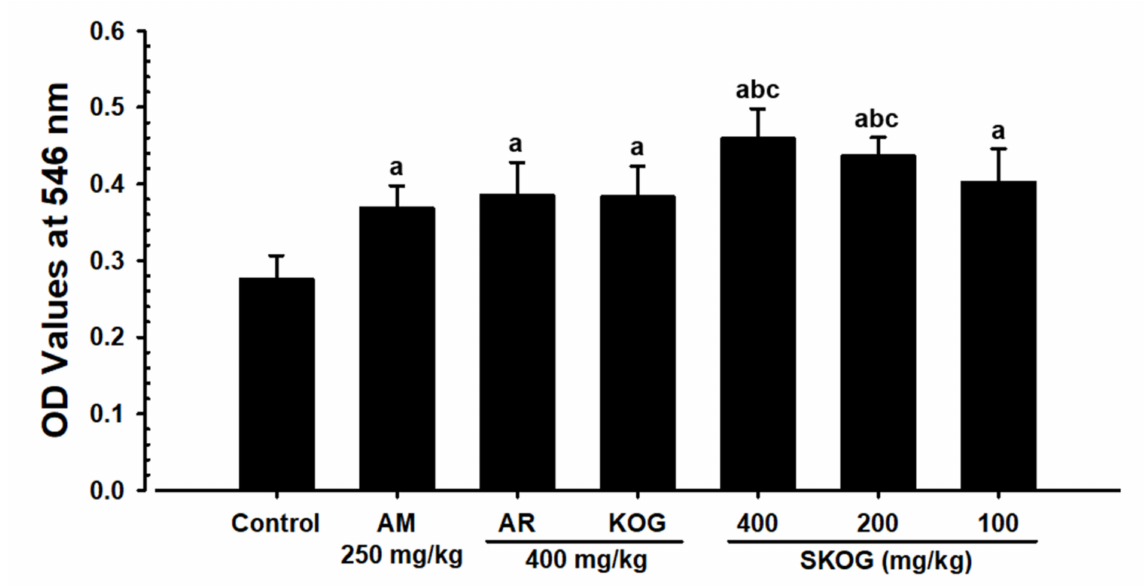
Figure 4. Effects of AR, KOG, and SKOG on mucous secretions in the trachea of mice. Values are shown as the mean ± SD of 10 mice. Different letters indicate statistical significance. Treatment groups expressed as a p < 0.01, b p < 0.01, and c p < 0.01 compared with the intact vehicle control, AR 400 mg/kg, and KOG 400 mg/kg by the LSD test,